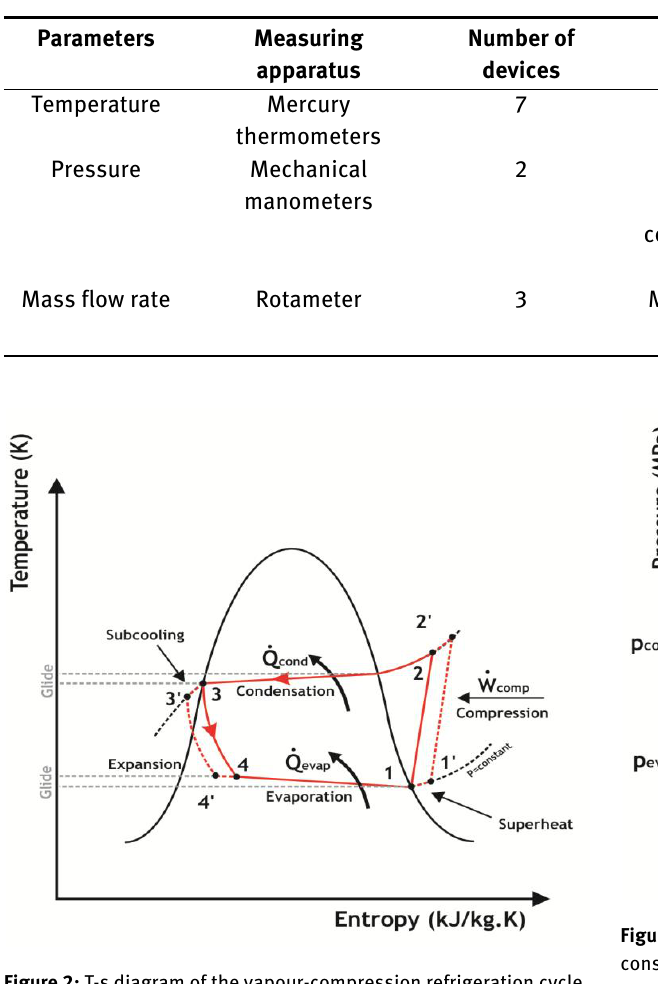
Figure 2: T-s diagram of the vapour-compression refrigeration cycle considered in Fig. 1.